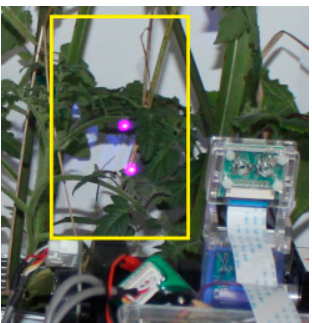
Figure 16. Sometimes under the operation, the laser beam was split into two beams as the violet spots show, resulting in damage of crop plants.